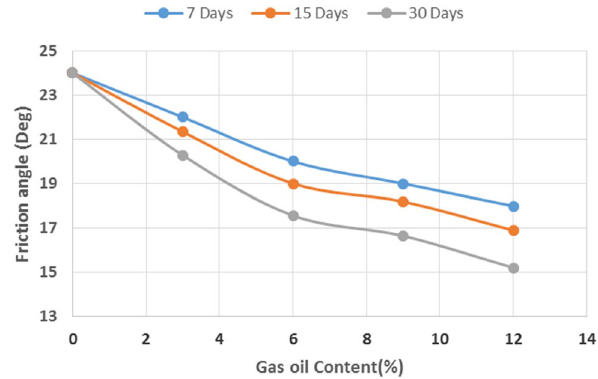
Fig. 19 Friction angle variations at different percentages of gaso- line and different